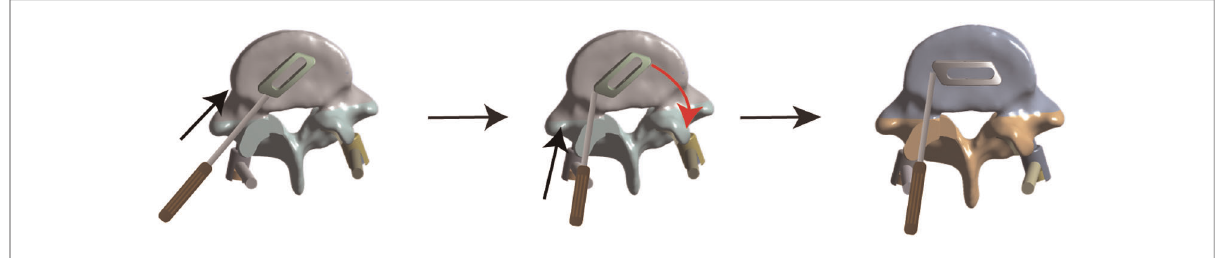
FIGURE 1 Diagram of cage traverse